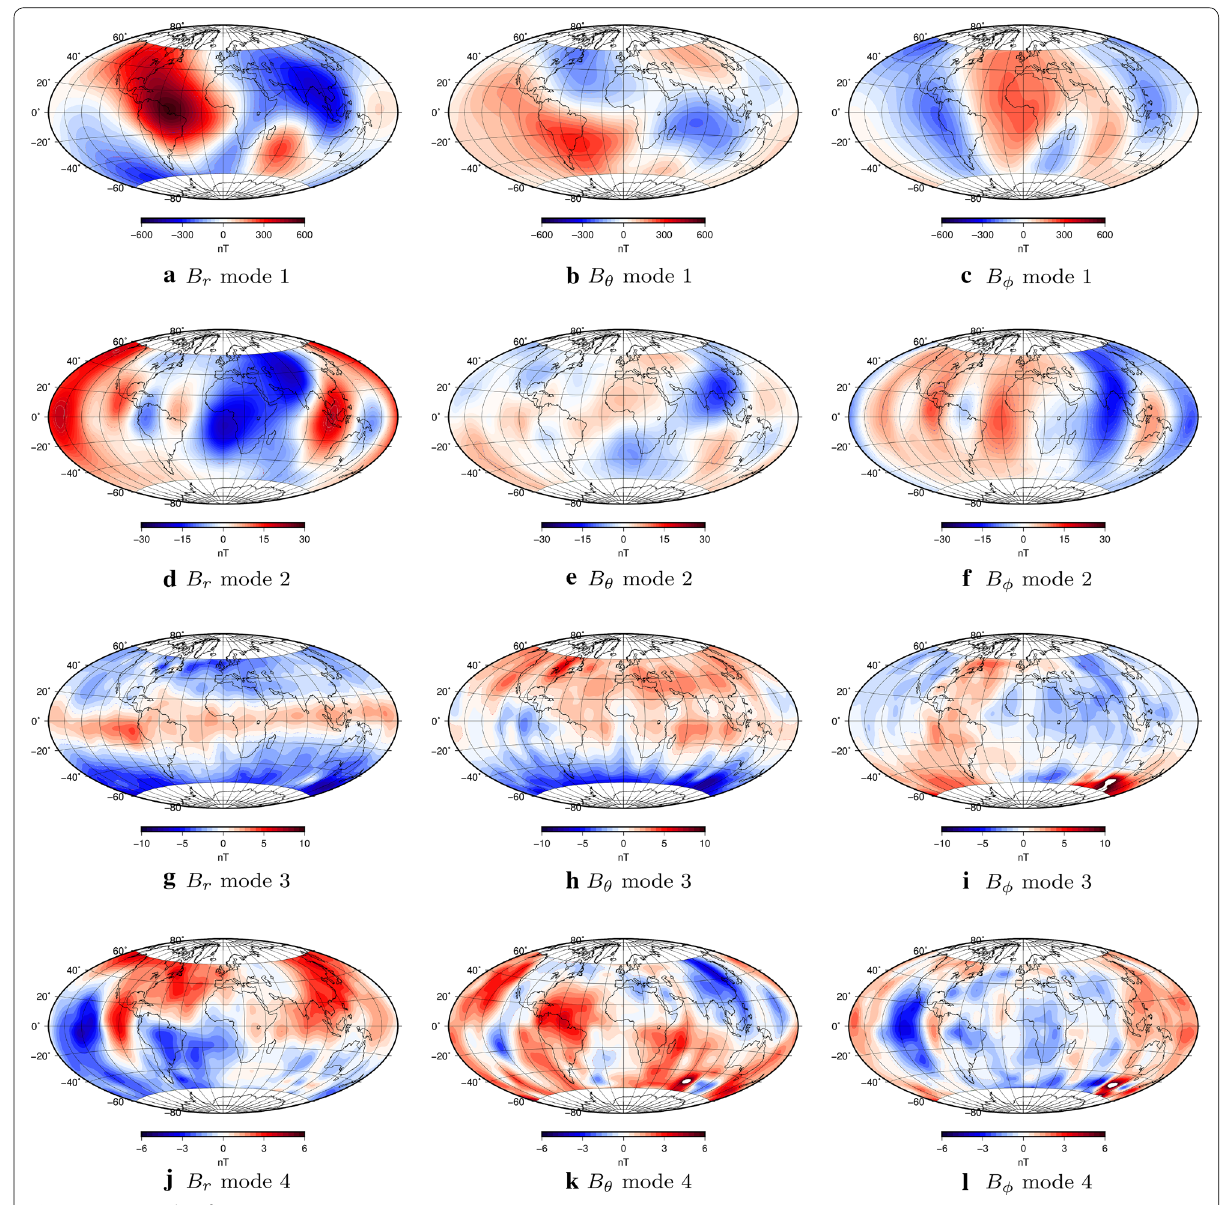
Fig. 5 As in Fig. 4 but from